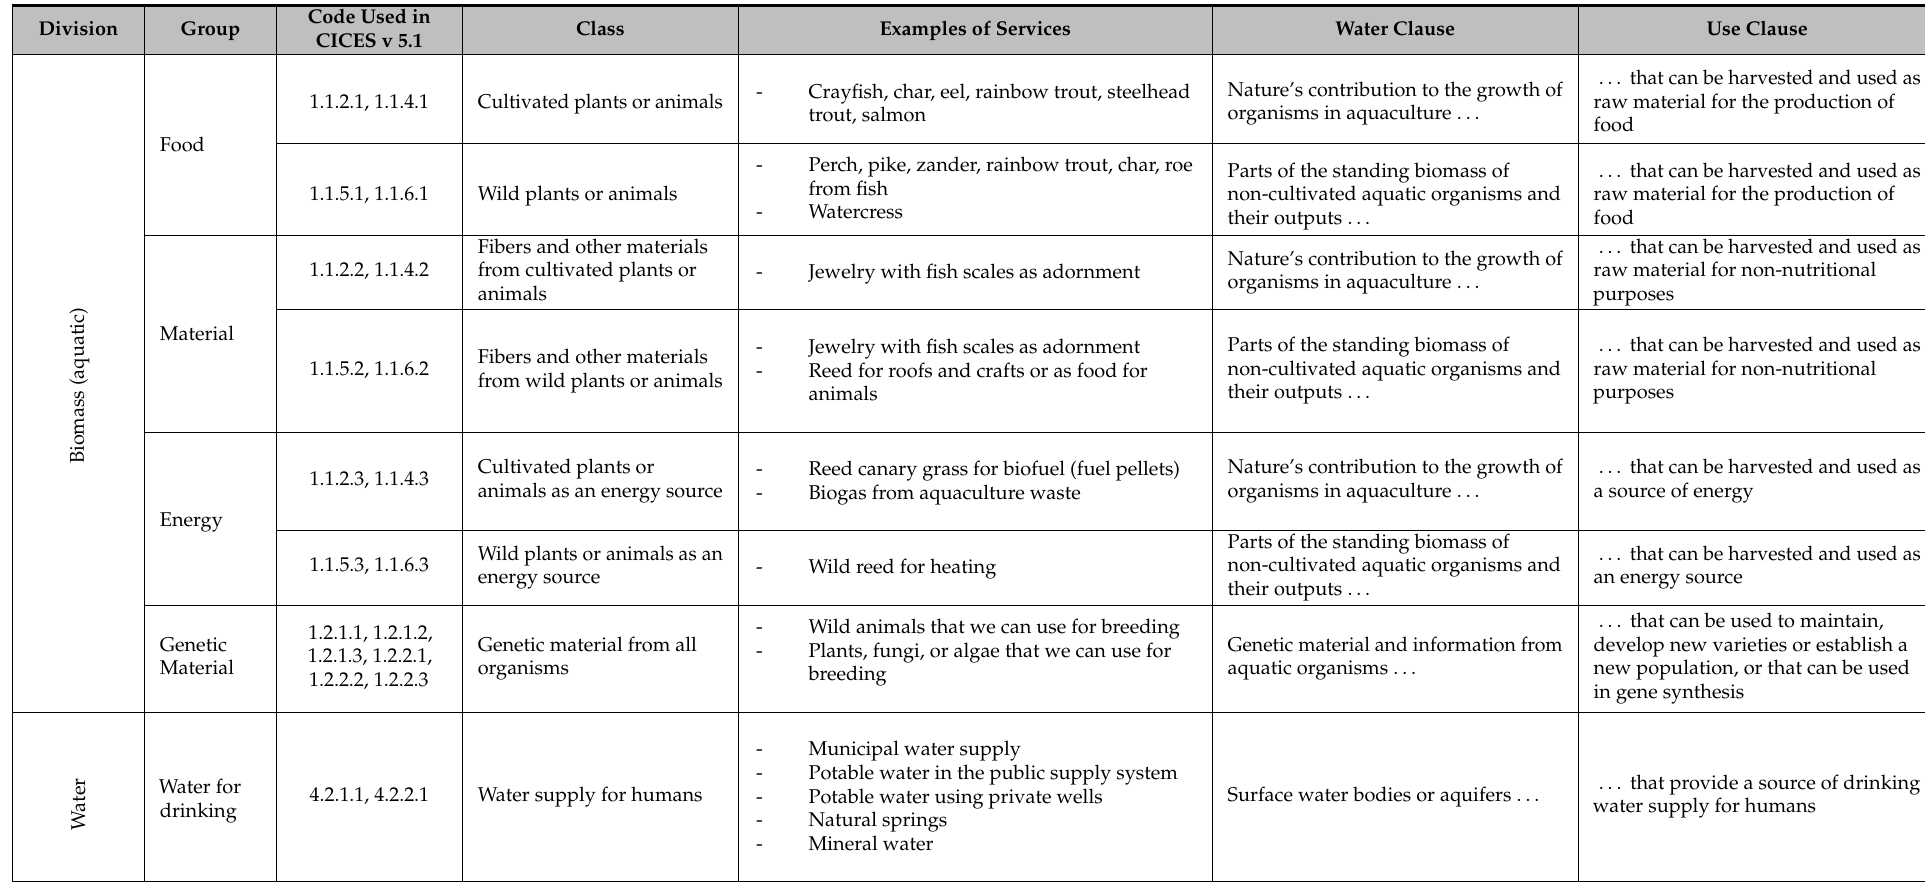
Table A1. Provisioning services. The water clause and use clause define the